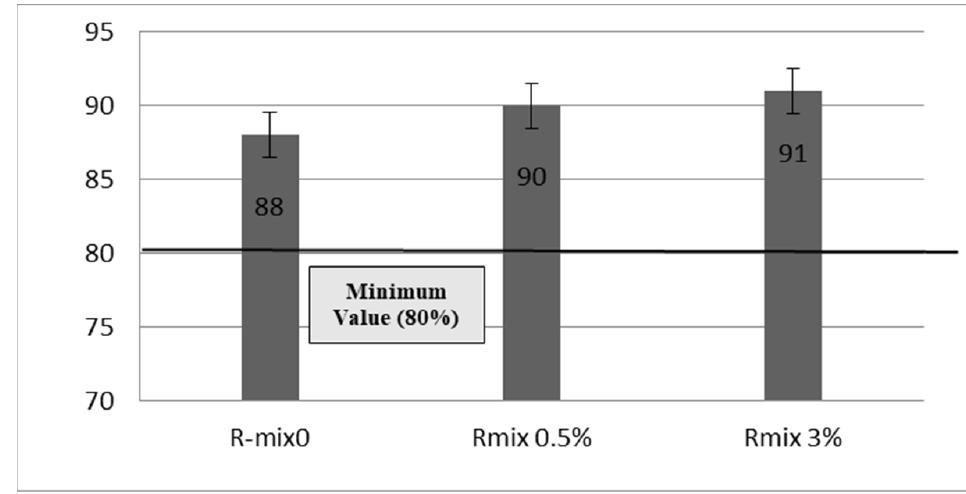
Figure 13. TSR for different asphalt mixes .